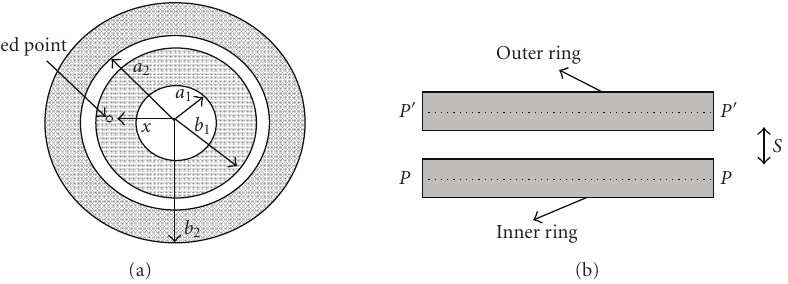
Figure 1: (a) Concentric annular ring microstrip antenna. (b) Parallel gap-coupled microstrip lines.